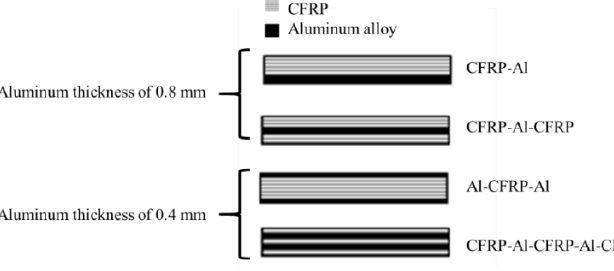
Figure 21. CML configurations studied by Carbas et al. [155].